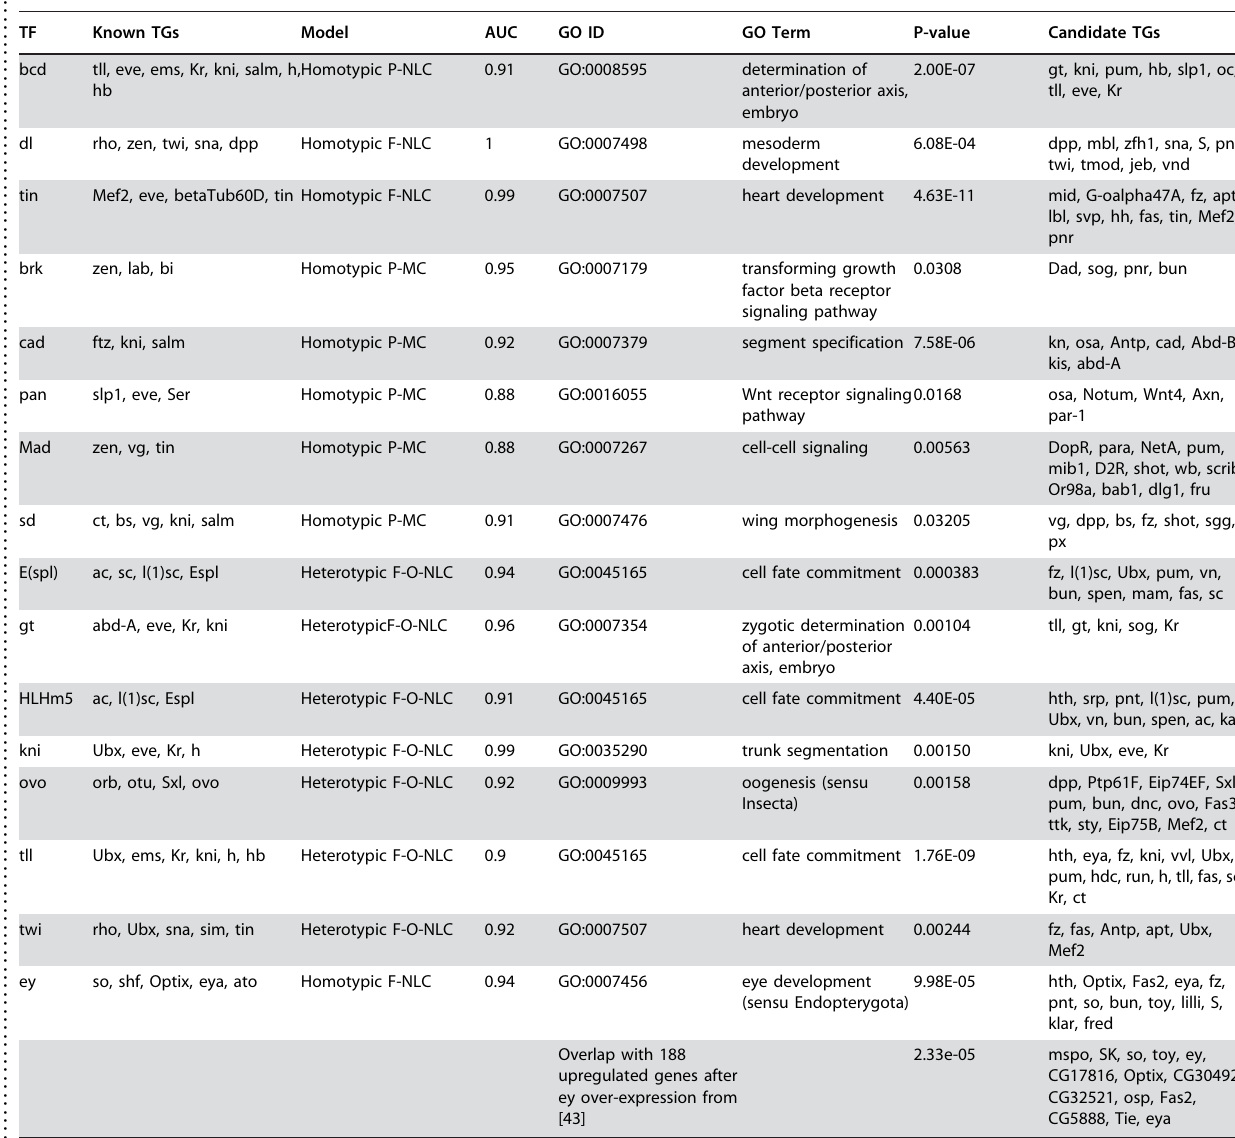
Table 1. Selection of GO-filtered genome-wide target gene predictions from our website. .. ... .... ... ... .... ... ... .... ... ... .... ... ... .... ... ... .... ... ... .... ... ... .... ... ... .... ... ... .... ... ... .... ... ... .... ... ... .... ... ... .... ... ...